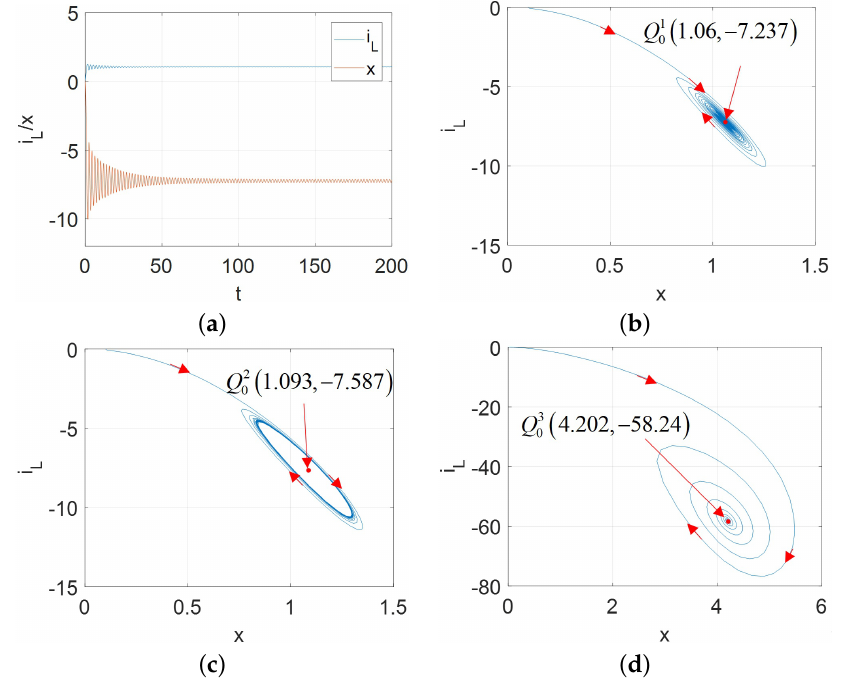
Figure 19. v 1 (cid:101) [ − 2.155, − 1.5 ] and initial condition [ x ( 0 ) , i L ( 0 )] = [ 0.1,0 ] for A = A FL : ( a ) x ( t ) and i L ( t ) for v = − 2.17 V; ( b ) stable limit cycle converges to Q 1 limit cycle corresponding to the periodic waveforms for v 1 = − 2.0 V; ( d ) stable limit cycle converges to Q 3 (4.202, − 58.24) for v = − 1.4. 0